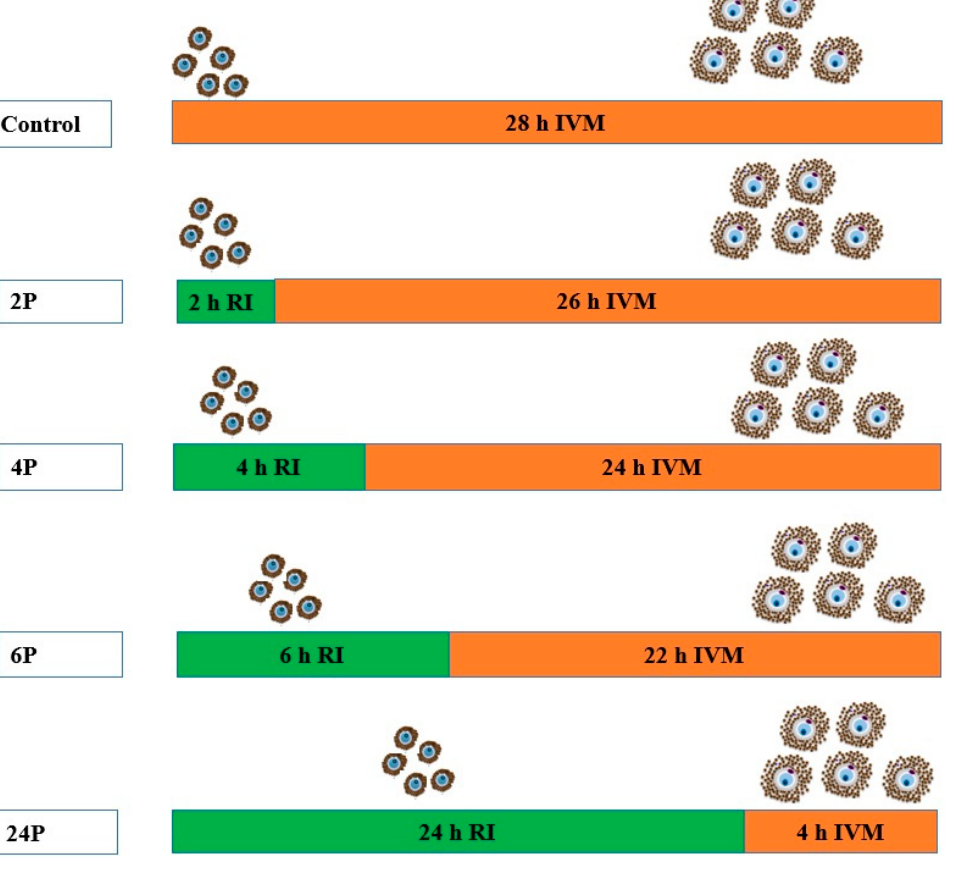
Figure 1. The experimental design of biphasic in vitro maturation (IVM) and prematuration (Pre-IVM). Phase 1: Cumulus–oocyte complex (COC) in vitro maturation medium was supplemented with Rho-associated protein kinases (ROCK) inhibitor (Y-27632) for 2 h, 4 h, 6 h, and 24 h vs. control group without RI. Phase 2: COCs were transferred to plain IVM medium to complete the maturation for 28 h (i.e., 26 h, 24 h, 22 h, and 4 h,